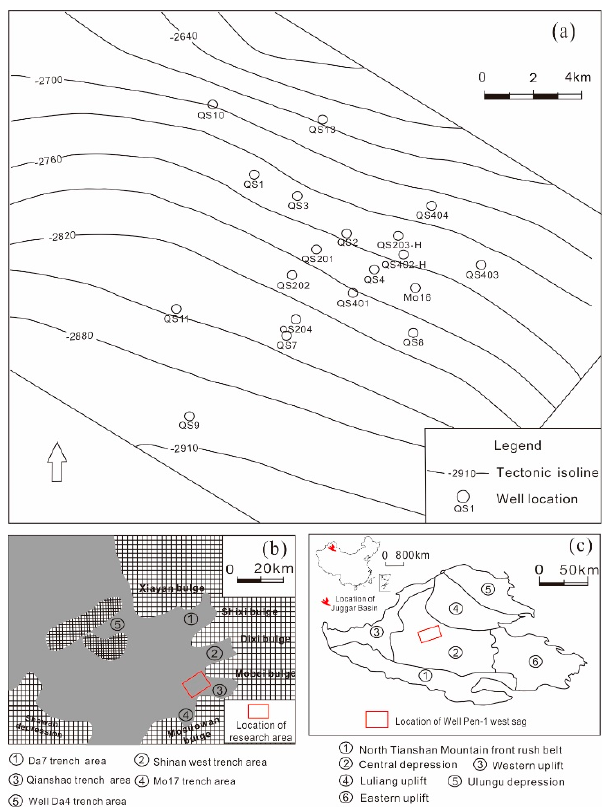
Figure 1. Structural location map of Qianshao area. ( a ) Well location distribution map of Qianshao area; ( b ) Structural unit distribution map of Well Pen-1 west sag; ( c ) Structural unit distribution map of Junggar